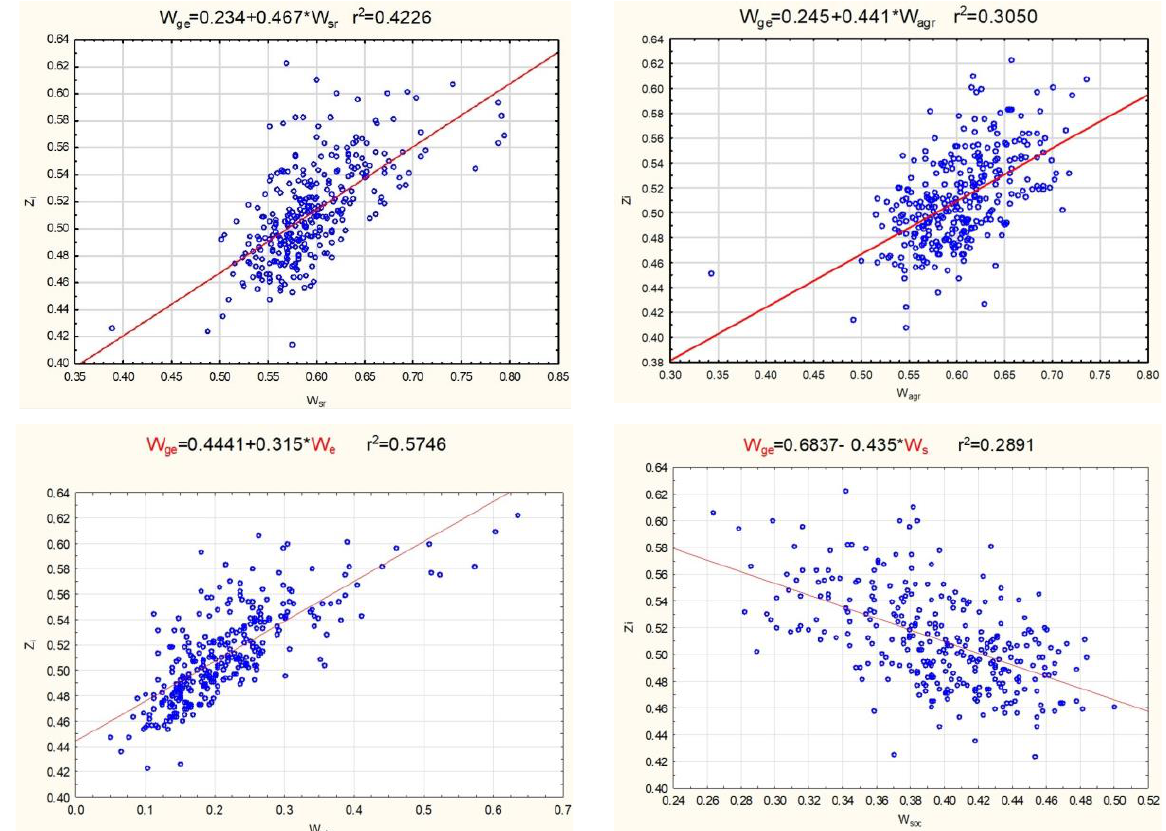
Figure 8. Relationship between the development of green economy (W ge ) and the environmental dimension of the quality of life (W n ), development of agriculture (W agr ), economic dimension of the quality of life (W e ) and social dimension of the quality of life (W s ). Source: own elaboration.